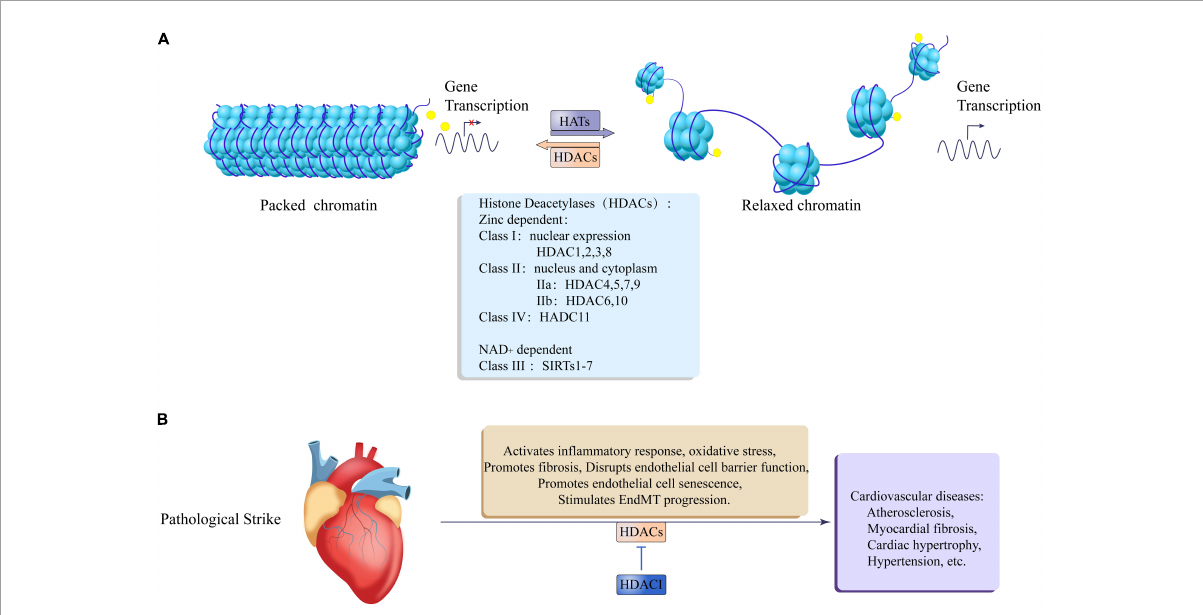
FIGURE3 Epigenetic regulation of histone acetylation and deacetylation in cardiovascular disease. (A) Histone acetyltransferases (HATs) relax packaged chromatin to promote gene transcription, and histone deacetylases (HDACs) promote chromatin packaging to inhibit gene transcription. The HDACs family is divided into zinc lipoprotein dependent and NAD + dependent, Zinc lipoprotein dependent enzymes include: class I: HDAC1, 2, 3, 8, which are mainly expressed in the nucleus; class II: IIa: HDAC4, 5, 7, 9; IIb: HDAC6, 10, which are expressed in both the nucleus, nucleus, and cytoplasm; class IV: HDAC11. NAD + dependent enzymes include: Class III: SIRTs1-7. (B) After the heart is pathologically stimulated, HDACs can activate an inflammatory response and oxidative stress, promote fibrosis, damage endothelial cell barrier function, and promote endothelial cell senescence and EndMT process leading to cardiovascular diseases such as atherosclerosis, myocardial fiber Cardiac hypertrophy, hypertension, etc. At the same time, HDACI Can antagonize the adverse effects of